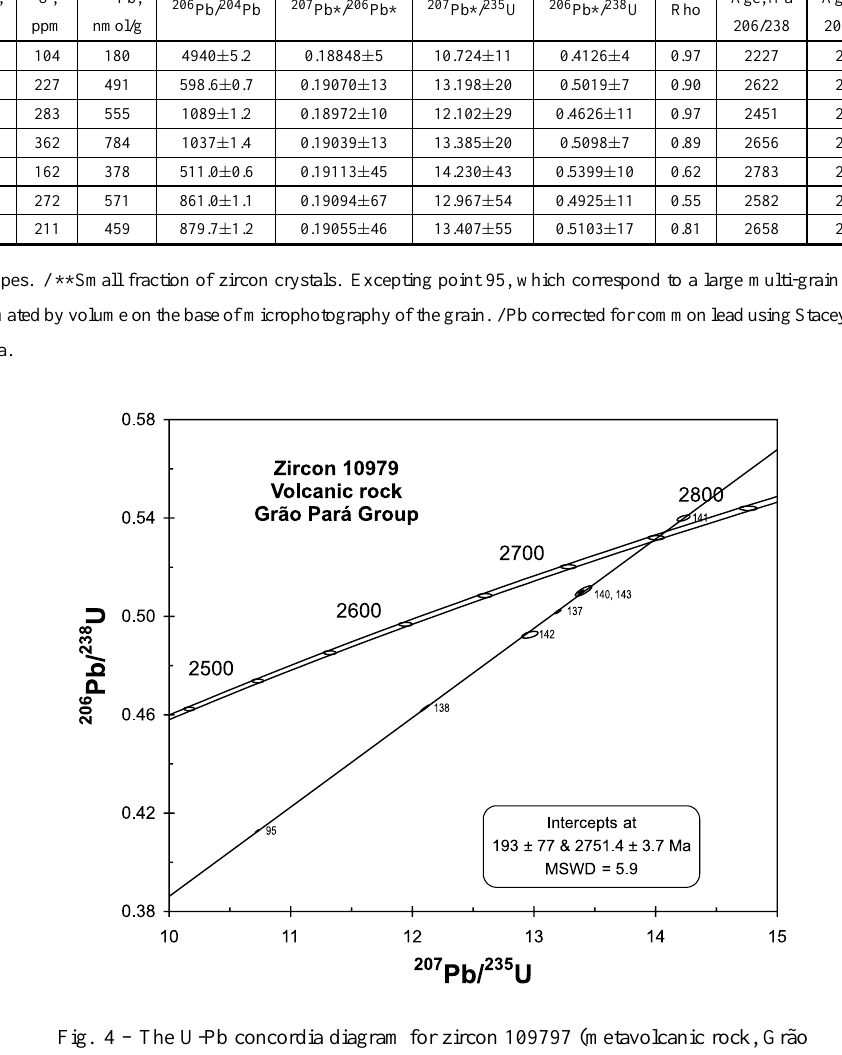
Fig. 4 – The U-Pb concordia diagram for zircon 109797 (metavolcanic rock, Grão Pará group) using 235 U- 208 Pb “ IPGG” spike.